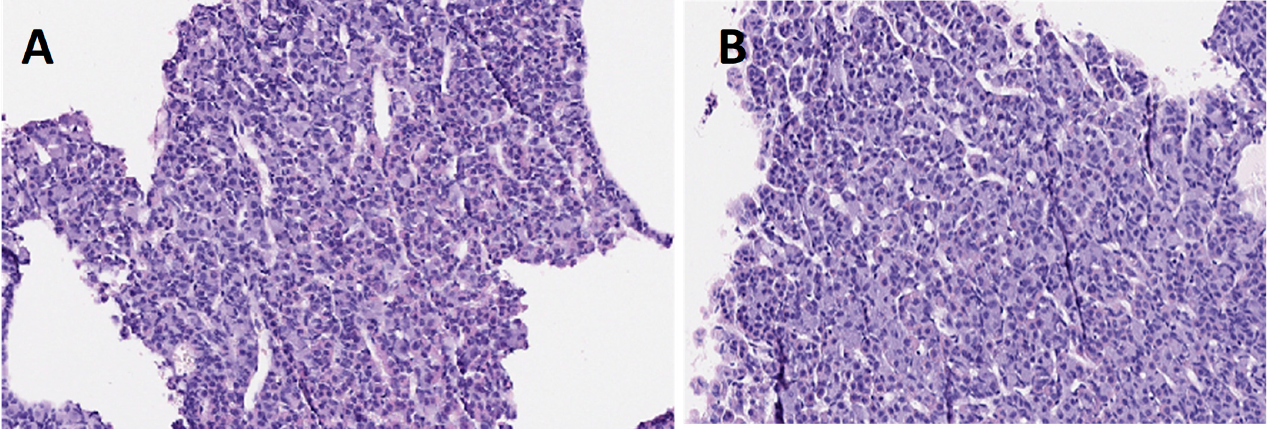
Figure 9. Histological sections of the hypophysis of the control group ( A ) and group G5 ( B ), (H-E 20×).